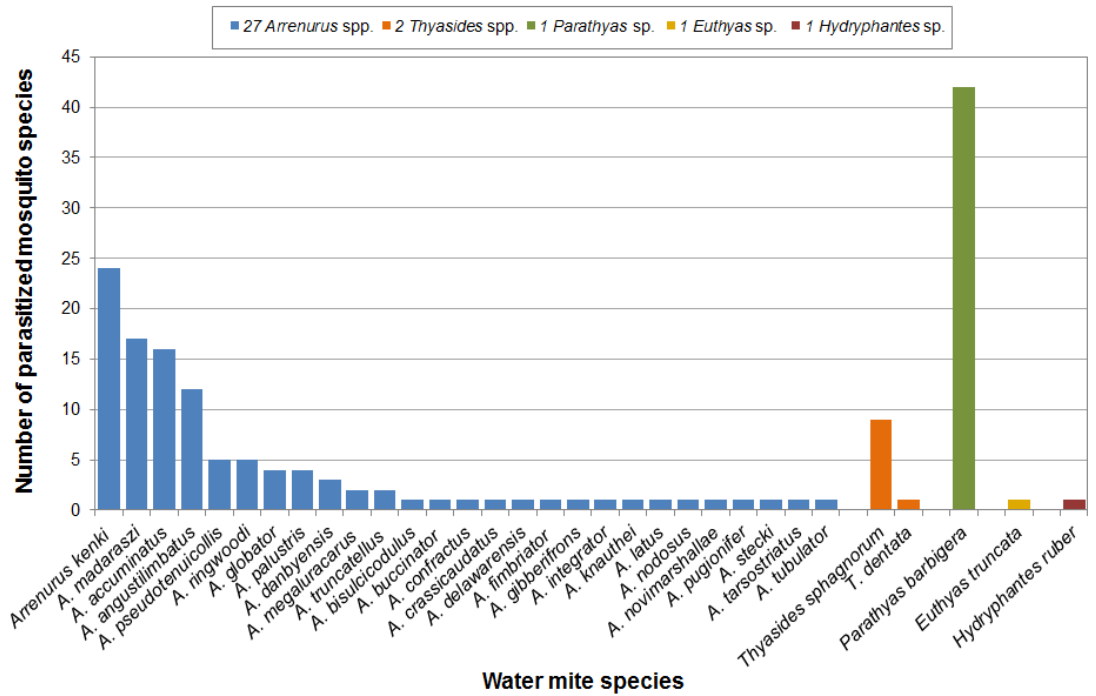
Figure 5. Water mites identified according to species and the number of mosquito species they parasitize, from Atwa, Bilgrami, and Al-Saggaf [36]; Leal dos Santos [43]; Manges, Simmons, and Hutchinson [37]; and Simmons and Hutchinson [34].